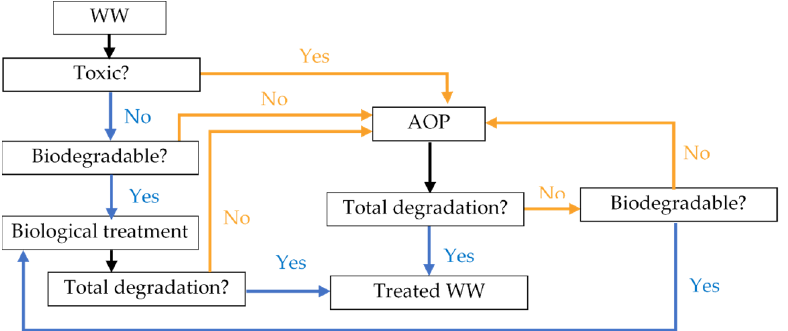
Figure 4. Combination of advanced oxidation technologies and bioremediation processes. WW: Wastewater, AOP: Advanced oxidation processes. Source: Adapted from [7].